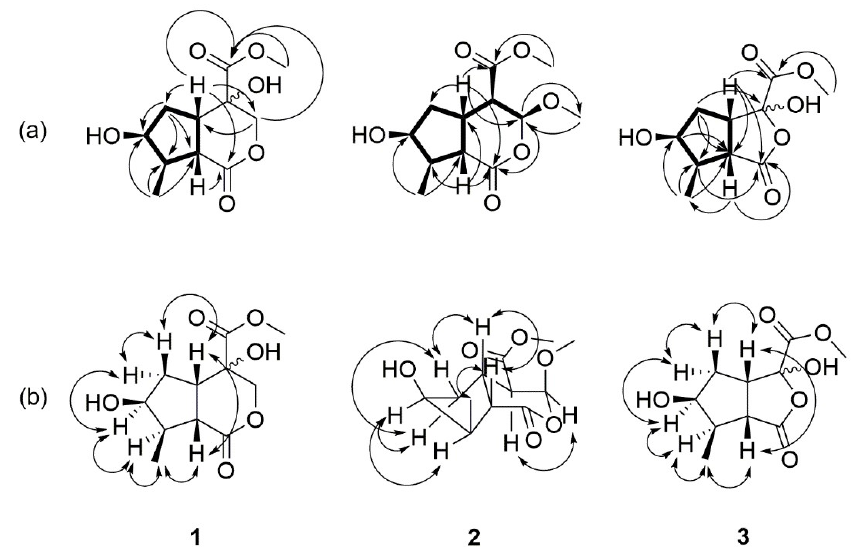
Figure 2. ( a ) Significant correlation spectroscopy (COSY) (bold line) and heteronuclear multiple bond coherence (HMBC) ( ) correlations for compounds 1 – 3 ( b ). Significant NOESY ( ) correlations of compounds 1 – 3 .